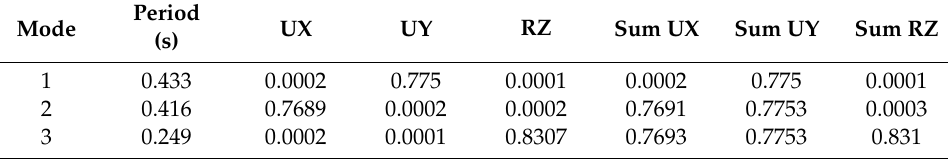
Table 7. Ratios of the modal participating mass after the reducing of the torsion.